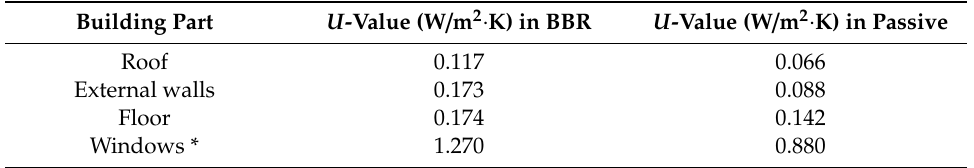
Table 6. U-Values based on the BBR-2015 building code and an existing certified passive building in Sweden